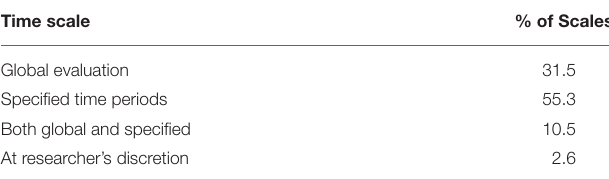
TABLE 6 | Global evaluation vs. specific time scales, N =